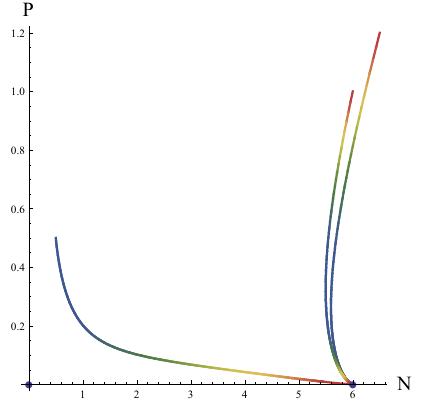
Fig. 8. Example 1. If the model (4) has no internal equilibria, then the boundary equilibrium E K = ( K, 0) is globally asymptotically stable